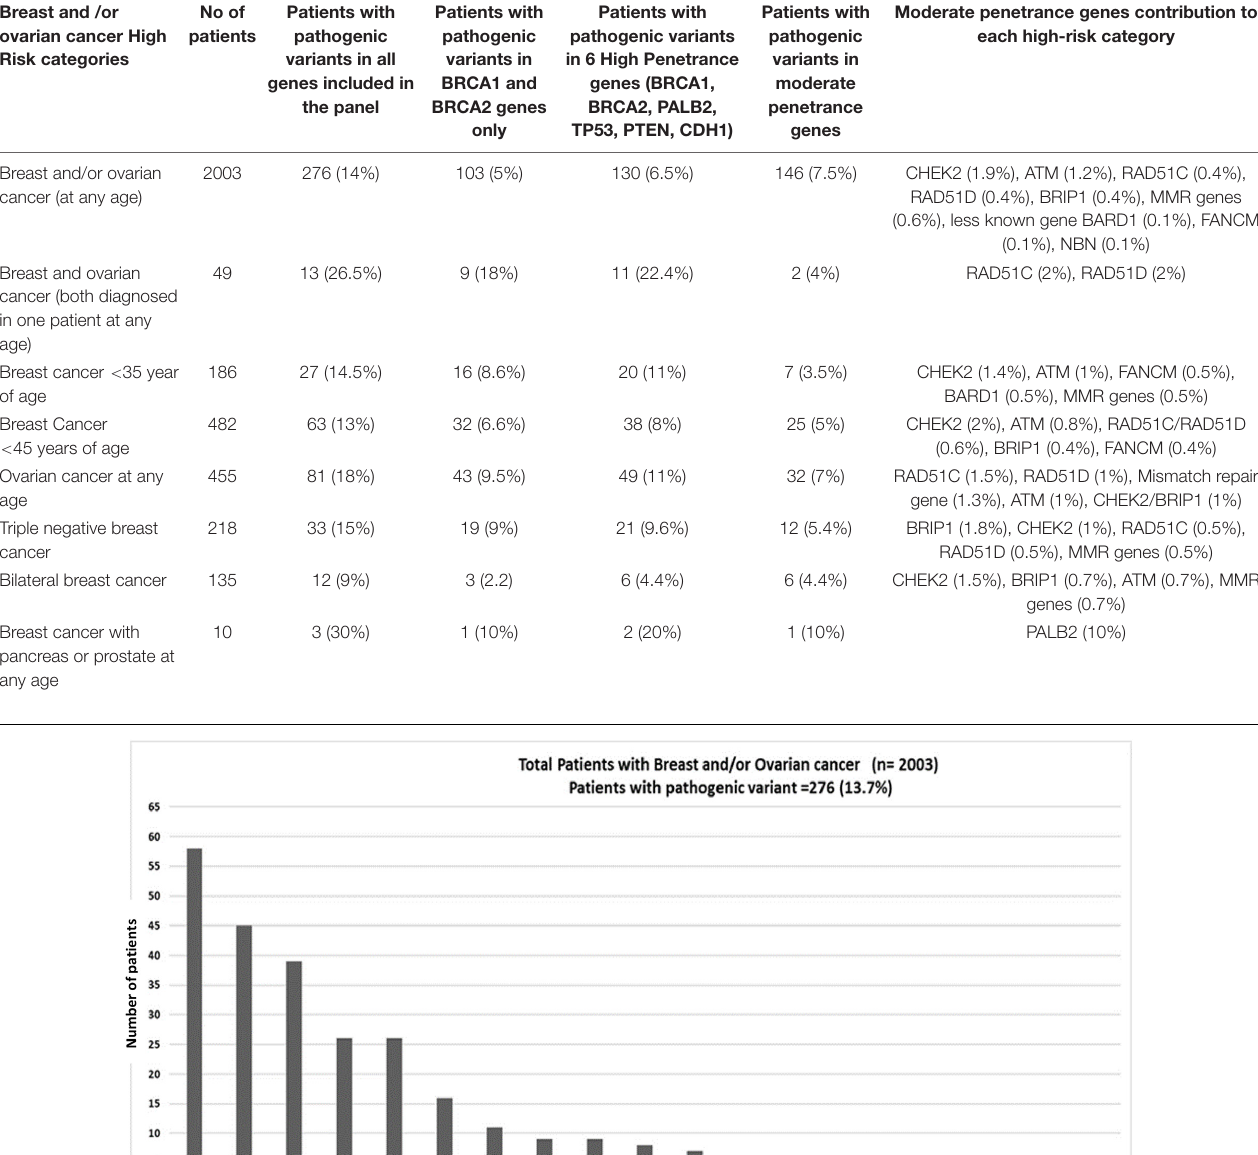
TABLE 3 | Frequency of pathogenic variants in BRCA1 and 2 genes, other high and moderate penetrance genes in various high-risk categories of patients with breast and/or ovarian cancer. Breast and /or ovarian cancer High